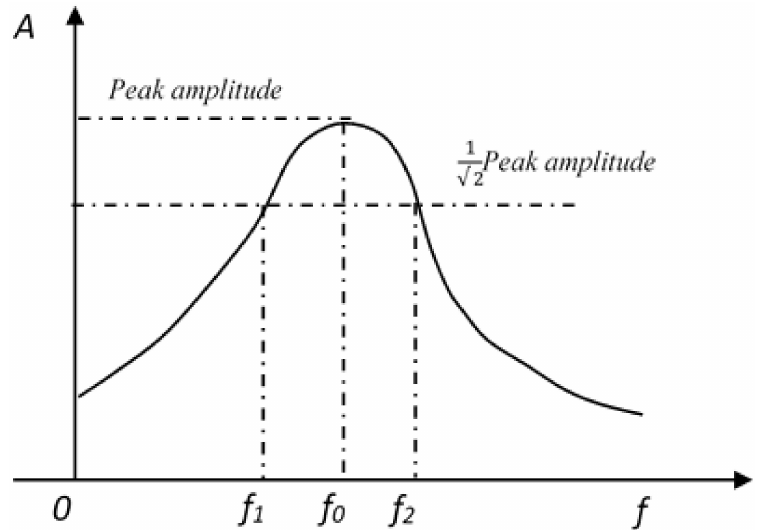
Figure 6. The half-power bandwidth method for the estimation of the damping ratio of the cement